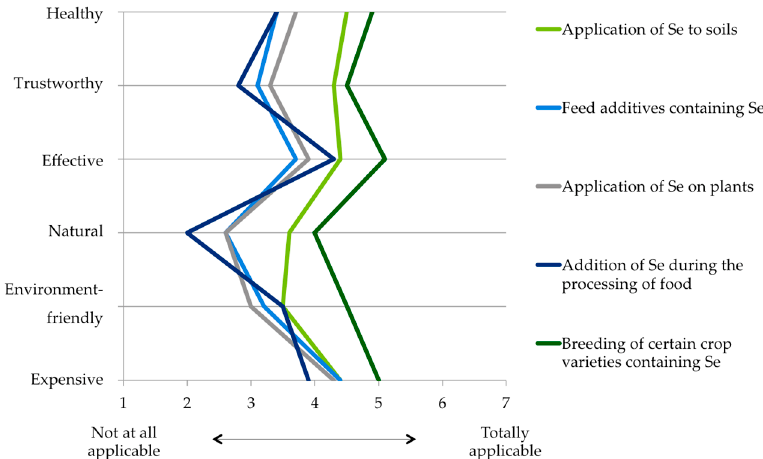
Figure 4. Evaluation of different methods to increase the Se content in food. Study participants were asked: “From your point of view, how strongly do the following characteristics (e.g., “Healthy”) apply to the different methods?” Possible scores ranged from one (“Not at all applicable”) to seven (“Totally applicable”). n = 238–258. For all mean values and standard deviations, refer to Table A2.